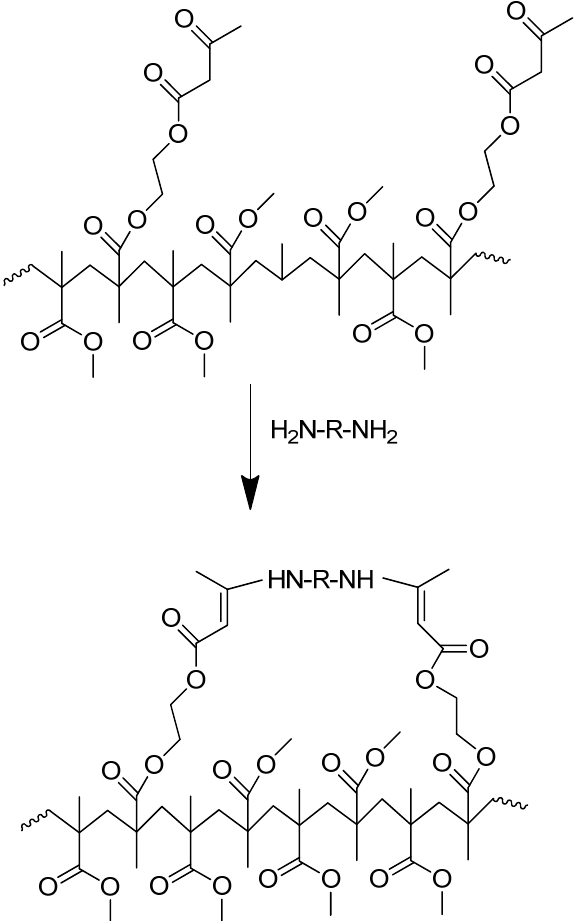
Figure 2. Enamine “click” chemistry route for the synthesis of ultra-small polymethyl methacrylate nanoparticles (PMMA-NPs).